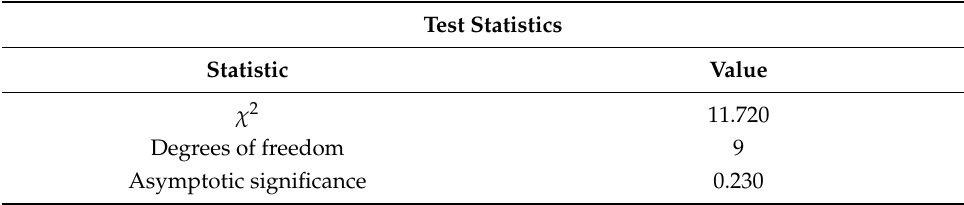
Table 3. χ 2 test statistical table.